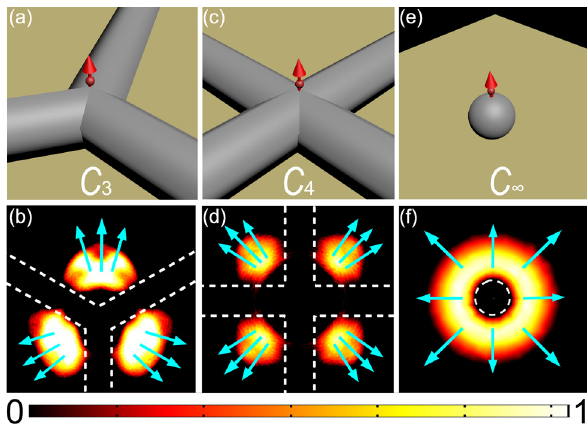
Figure 6: (a) Schematic diagram of Y-shaped silver nanowires on a gold substrate. A z -oriented dipole is located directly above ( d = 5 nm) the crossing point of the Y-shaped silver nanowires. (b) Intensity ( | E | 2 ) distribution in the x - y plane with z = 2 μ m. The white dashed lines are the pro fi le of the Y-shaped silver nanowires. (c) Schematic diagram of two orthogonal silver nanowires on a gold substrate. (d) Intensity ( | E | 2 ) distribution in the x - y plane with z = 2 μ m. The white dashed lines are the pro fi les of the two orthogonal silver nanowires. (e) Schematic diagram of a spherical silvernanoparticleonagoldsubstrate.(f)Intensity( | E | 2 )distribution in the x - y plane with z = 2 μ m. The white dashed lines are the pro fi le of the spherical silver